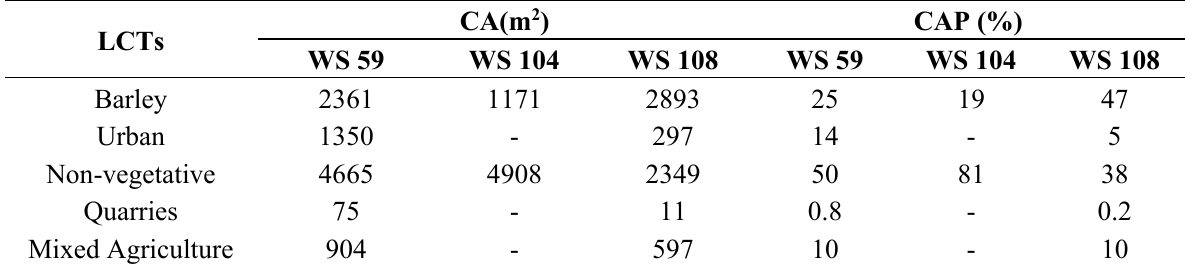
Table 4. Class Area and Class Area Proportion of all land cover type (LCT).